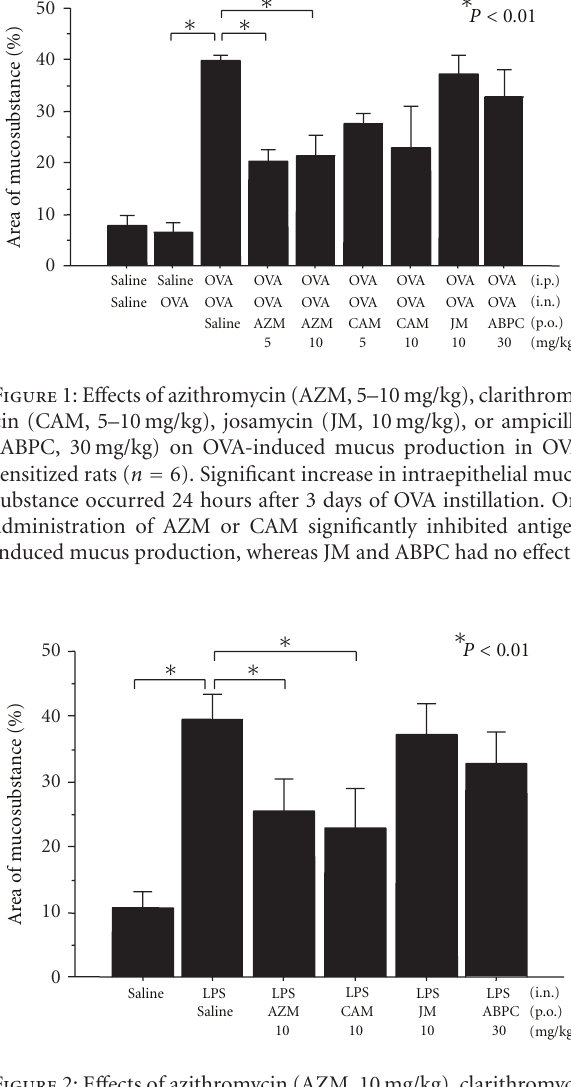
Figure 2: E ff ects of azithromycin (AZM, 10 mg/kg), clarithromycin (CAM, 10mg/kg), josamycin (JM, 10mg/kg), or ampicillin (ABPC, 30mg/kg) on LPS-induced mucus production in rat nasal epithe- lium ( n = 6). Significant increase in intraepithelial mucosubstance occurred 24 hours after 3 days of LPS instillation. Oral administra- tion of AZM or CAM significantly inhibited LPS-induced mucus production, whereas JM and ABPC had no e ff